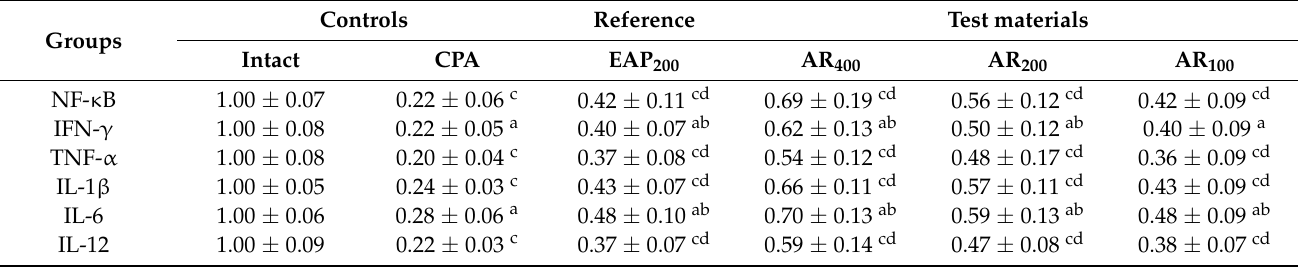
Table 7. Splenic cytokine mRNA expression in intact and CPA-induced immunosuppressed mice.